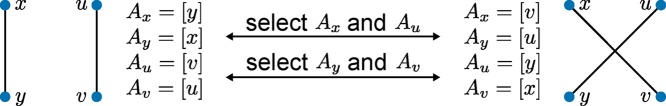
A switch corresponds to a trade of size one in the Undirected Curveball algorithm. Notice that each switch can be realized by two distinct trades: the switch from {x, y} and {u,v} to {x,v} and {u, y} can be realized by selecting Ax and Au and trading y for vor by selecting Ay and Av and trading x for u.